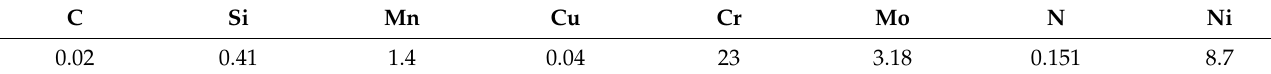
Table 2. ER2209 filler chemical composition requirements (%).